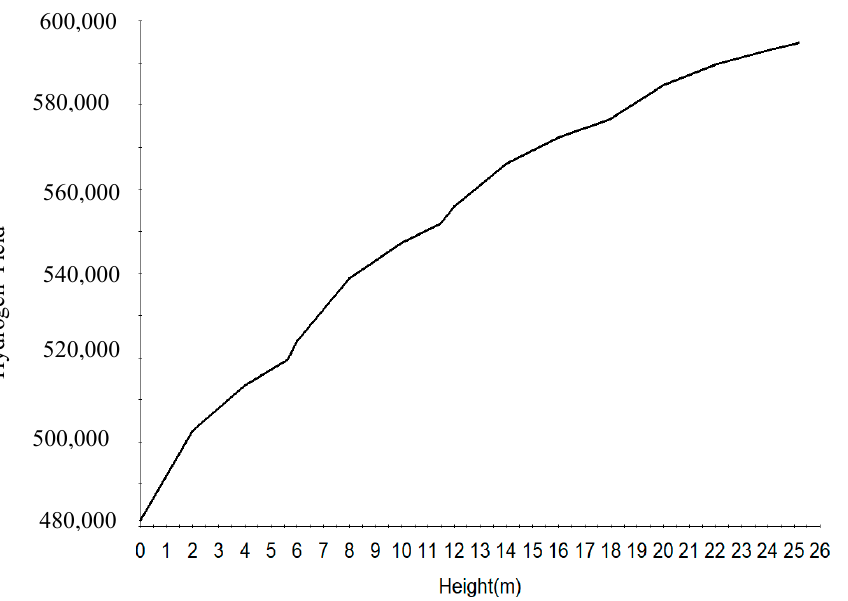
Figure 8. H 2 yield along the four reactors height.